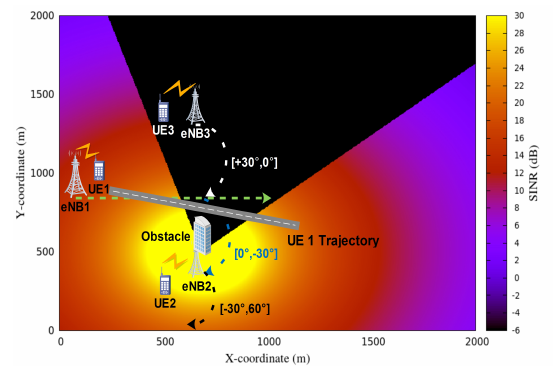
Figure 3: REM for eNB2 with Hard FR